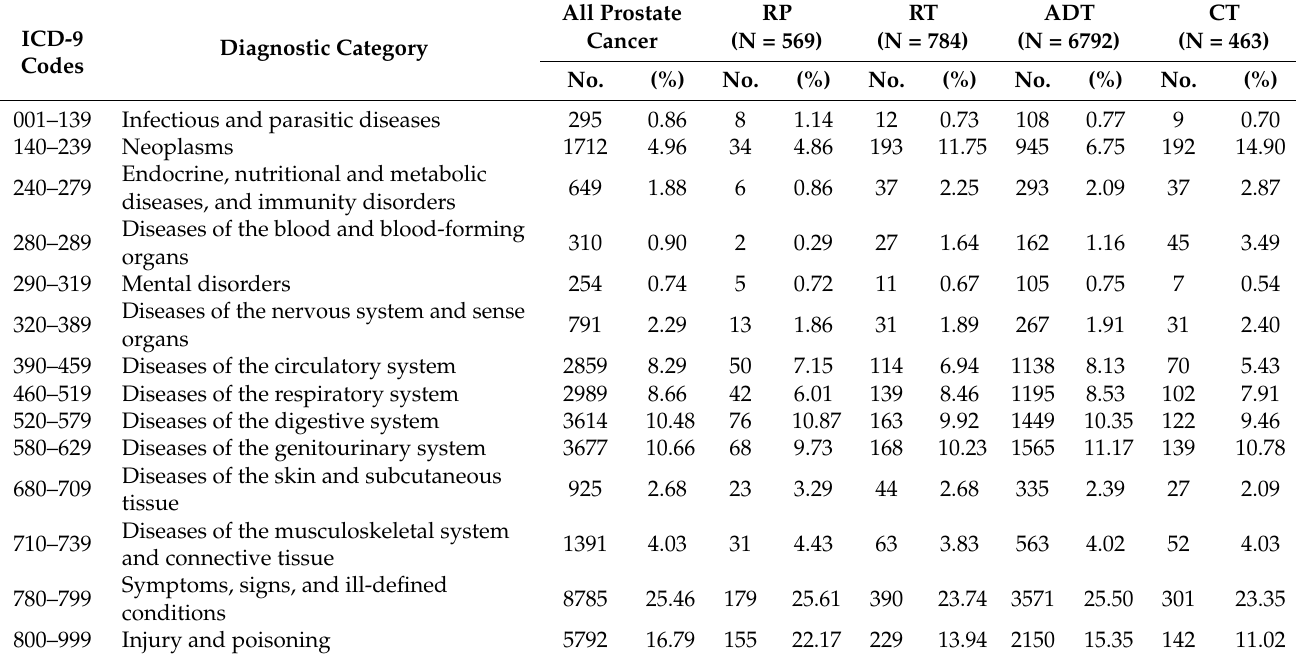
Table 3. Distribution of diagnostic categories of ED visits among patients with prostate cancer.